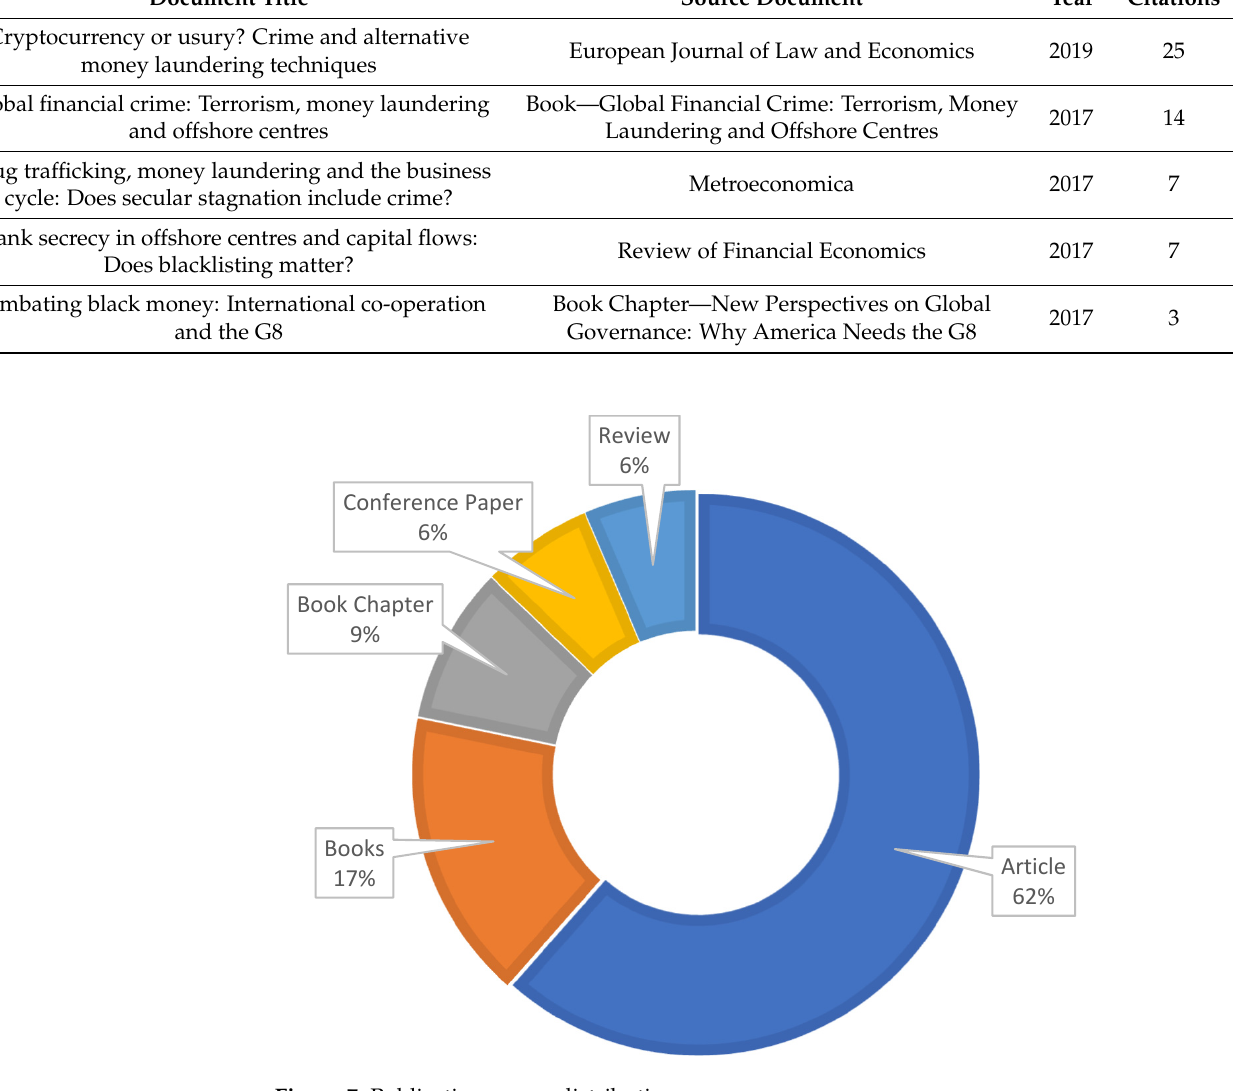
Figure 8. Documents by area of subject.